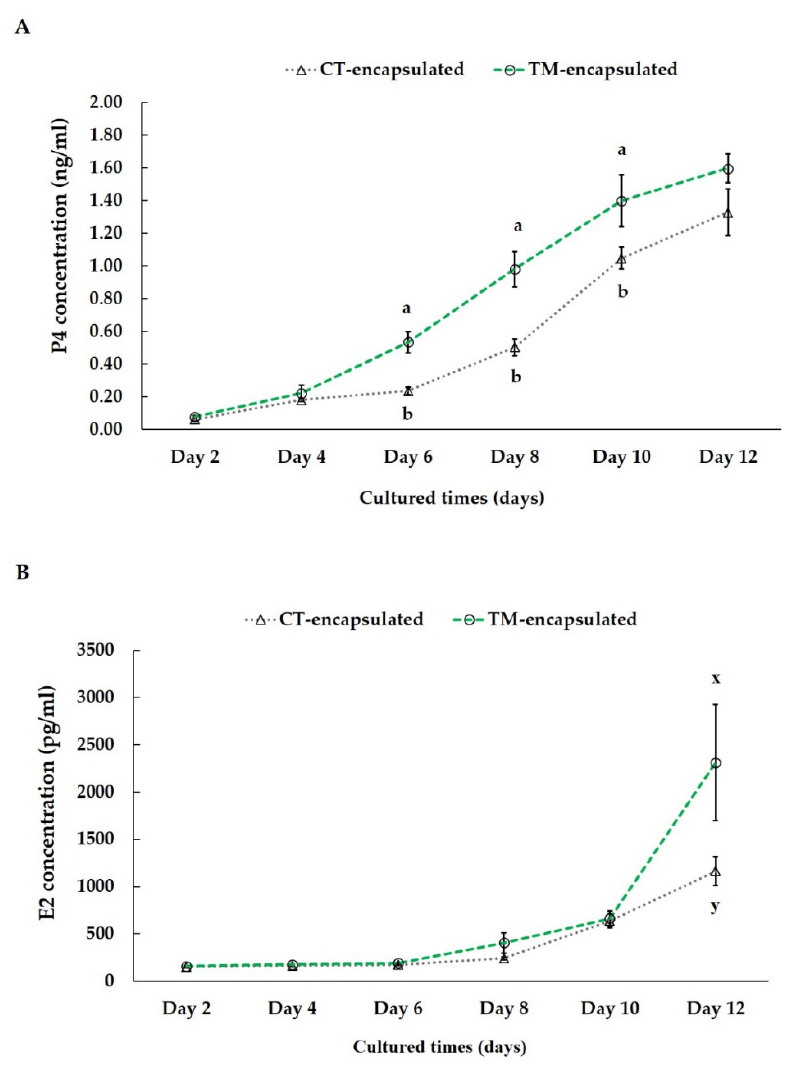
Figure 5. Concentrations of P4 ( A ) and E2 ( B ) in culture media on days 2, 4, 6, 8, 10, and 12 during follicle culture. Hormone concentration in the culture medium is presented on the Y-axis, and culture duration is presented on the X -axis. Outcomes are displayed as mean ± standard error of the mean. Different letters (a,b) indicate significant differences at p < 0.05, while different superscripts (x,y) tend to differ at 0.05 < p ≤ 0.10 between the two groups of follicles. Comparison between groups was performed using Student’s t -test. n = 3 measurements at each time point.